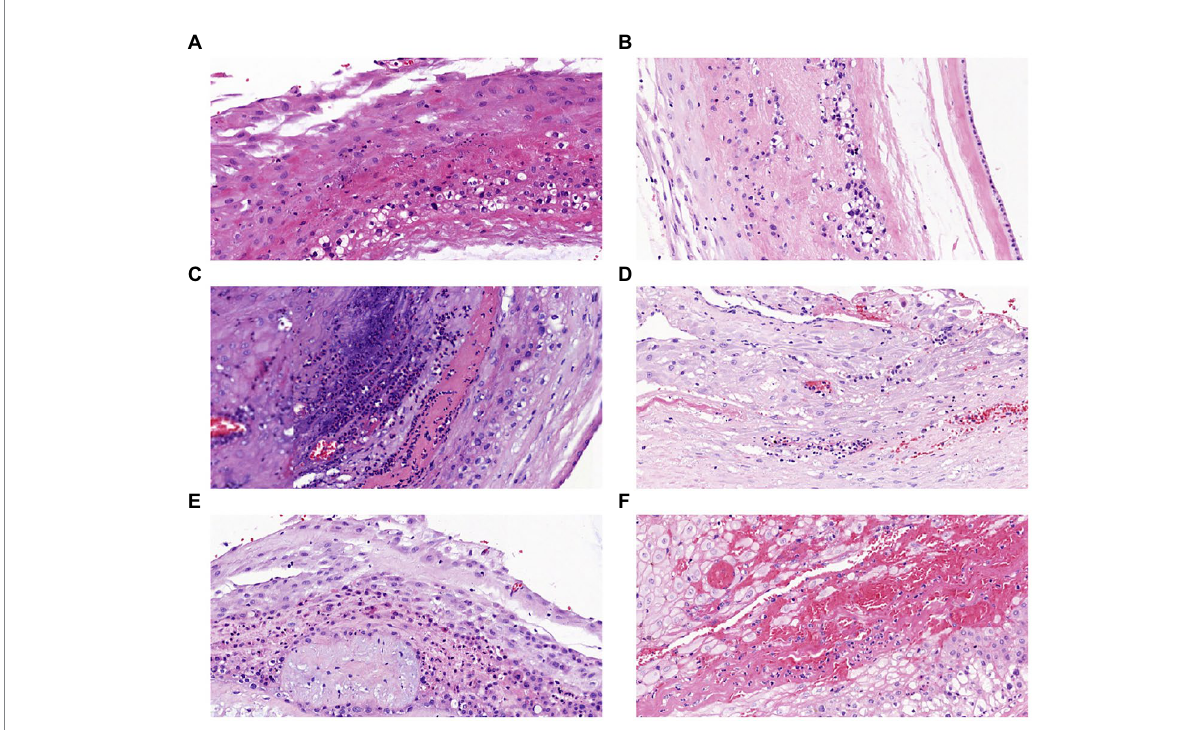
FIGURE 1 Placental histopathology chorioamnionitis (H&E × 200): (A) Stage I grade I, (B) Stage I grade II, (C) Stage I grade III, (D) Stage II grade I, (E) Stage II grade II, (F) Stage II grade III.